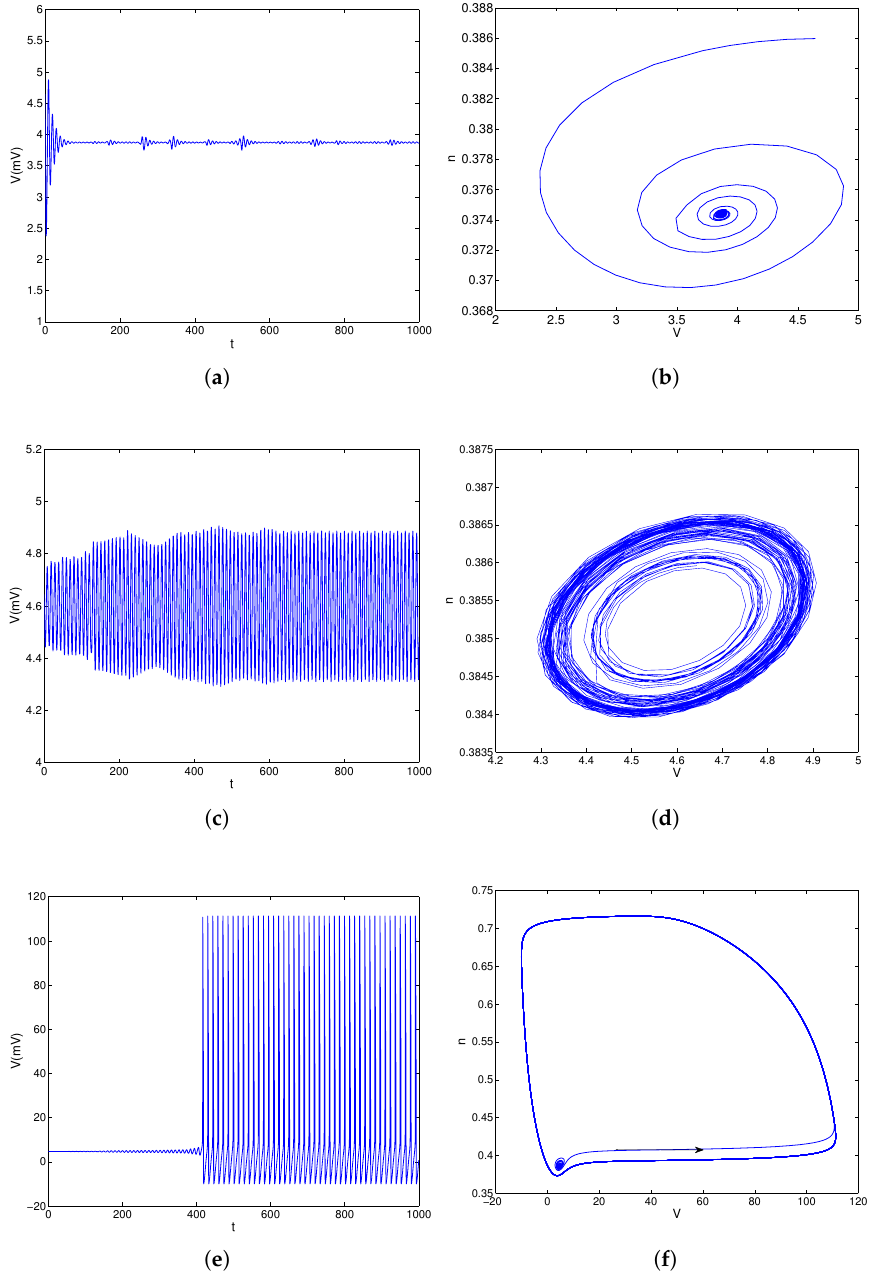
Figure 2. The convergent behaviors of model (28) about parameter I . ( a ) Response curve of trans- membrane voltage V for I = 6. ( b ) Trajectories in V − n phase plane for I = 6. ( c ) Response curve of trans-membrane voltage V for I = 7.41. ( d ) Trajectories in V − n phase plane for I = 7.41. ( e ) Response curve of trans-membrane voltage V for I = 7.51. ( f ) Trajectories in V − n phase plane for I =